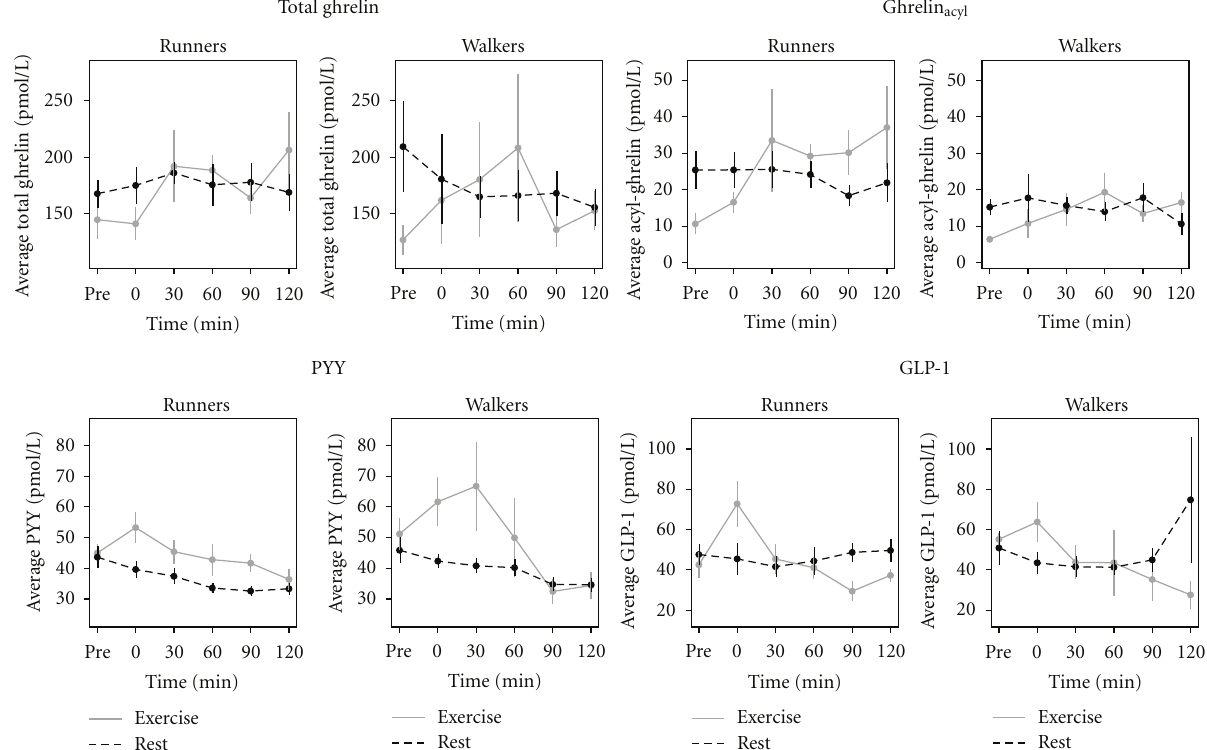
Figure 3: Average change in ghrelin (pmol/L, upper left panel), ghrelin acyl (pmol/L, upper right panel), PYY (pmol/L, lower left panel), and GLP-1 (pmol/L, lower right panel) for runners and walkers during exercise (solid grey) and rest (dashed black). “Pre” represents the time point just before exercise or rest. Vertical bars display the standard error of the mean concentration of gut peptide at that time point. postexercise slope (10.0 pmol/L per 30 minutes) and an